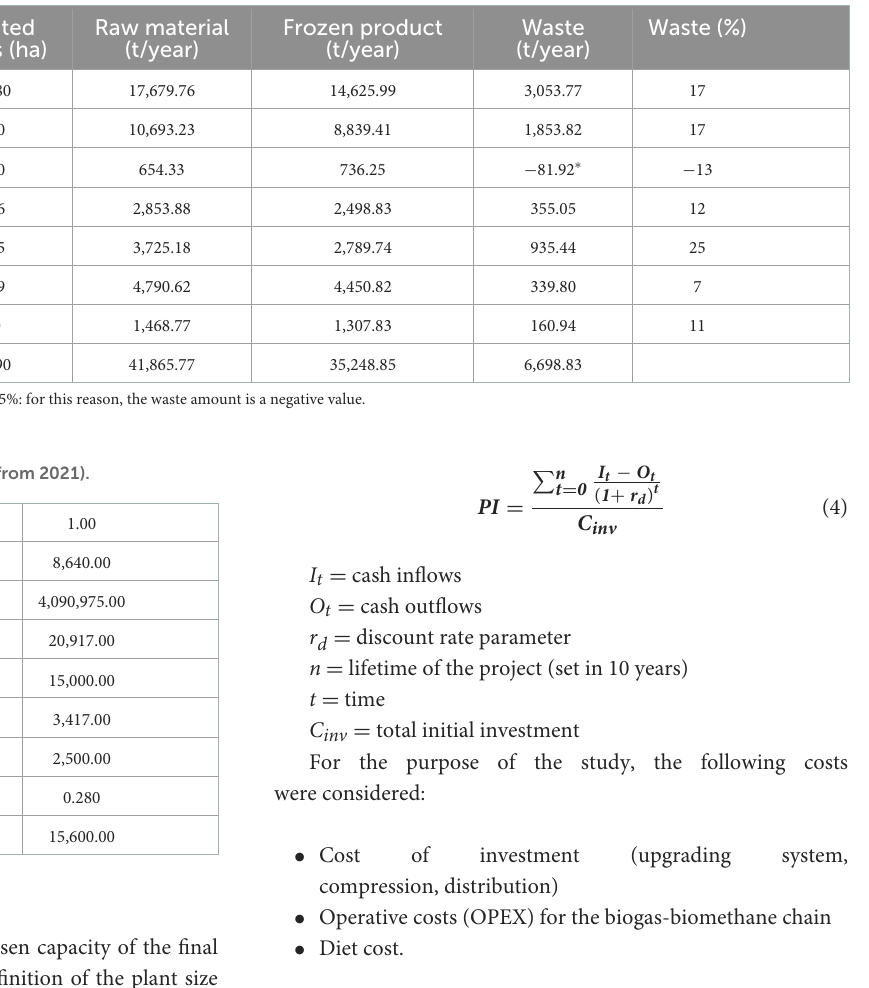
TABLE 1 Frozen vegetable supply chain mass balance (data from